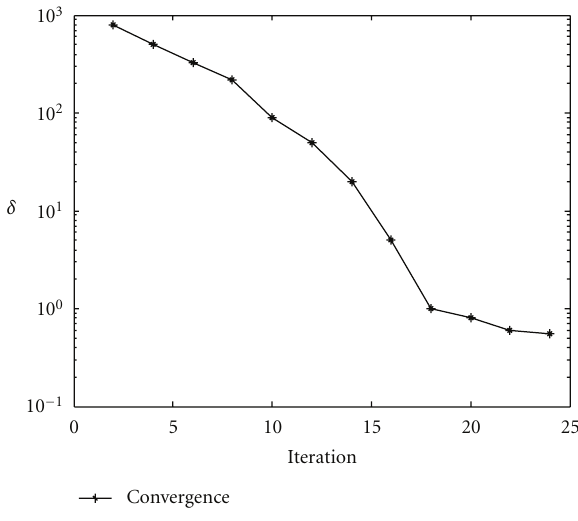
Figure 2: Performance of algorithmic